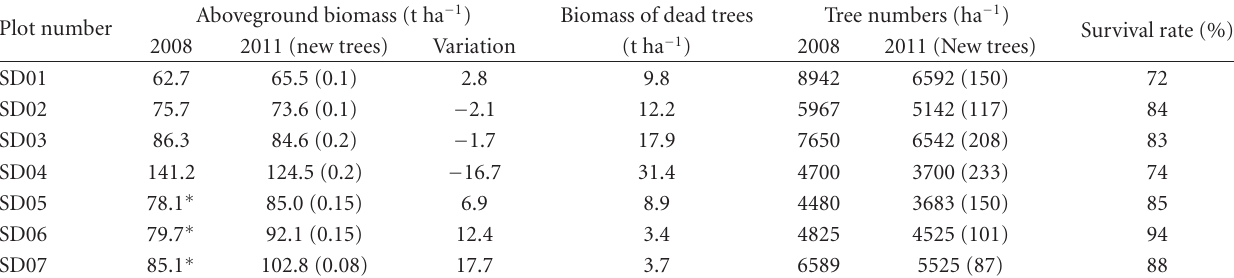
Table 6: Variation in biomass and tree numbers following the 2008 ice